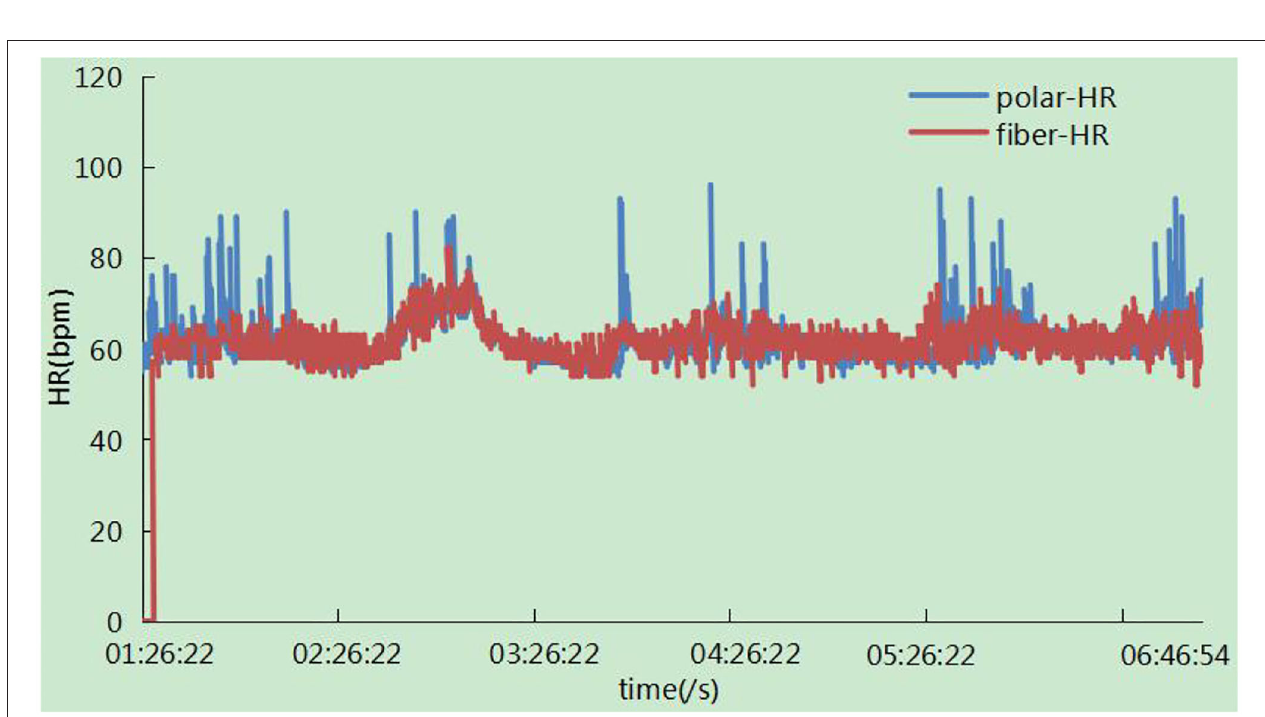
FIGURE 15 | Represents the heart rate measurement of our system in one night.